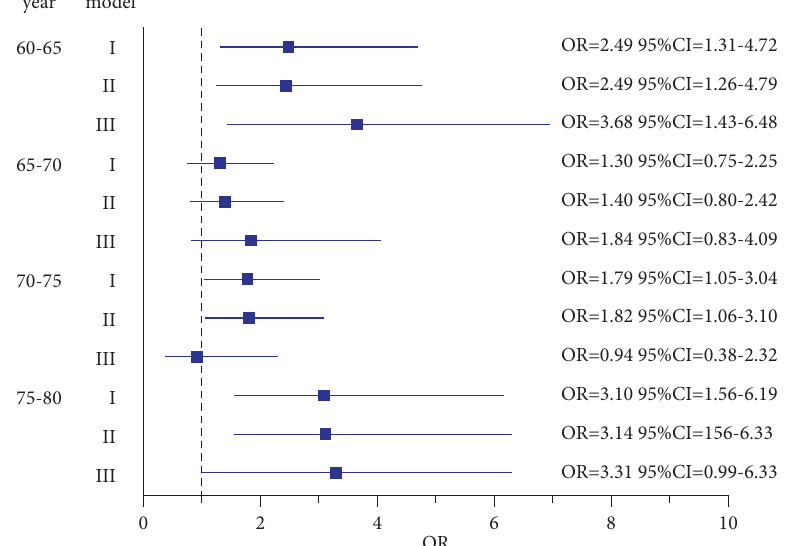
Figure 1: The relationship between the TyG index and LAA stroke determined using a logistic regression model. The dashed vertical line in the middle of the figure is invalid (odds ratio (OR) 1), and each horizontal line is a connection between the upper and lower limits of the (cid:31) 95% confidence interval (CI). The length of the line segment intuitively represents the values of the 95% CI. The small squares are the OR and reflect the weight of the research. The model I was unadjusted; model II was adjusted for hypertension, diabetes, smoking, and drinking; and model III was adjusted for SBP, TC, TG, and FBG based on model II.